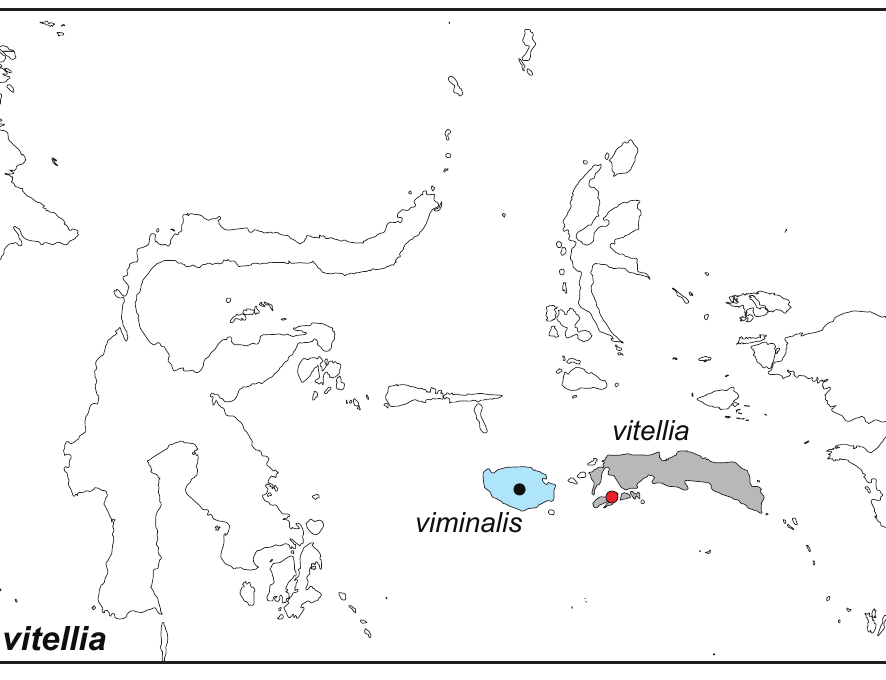
Figure 65. Distribution map of Elymnias vitellia .